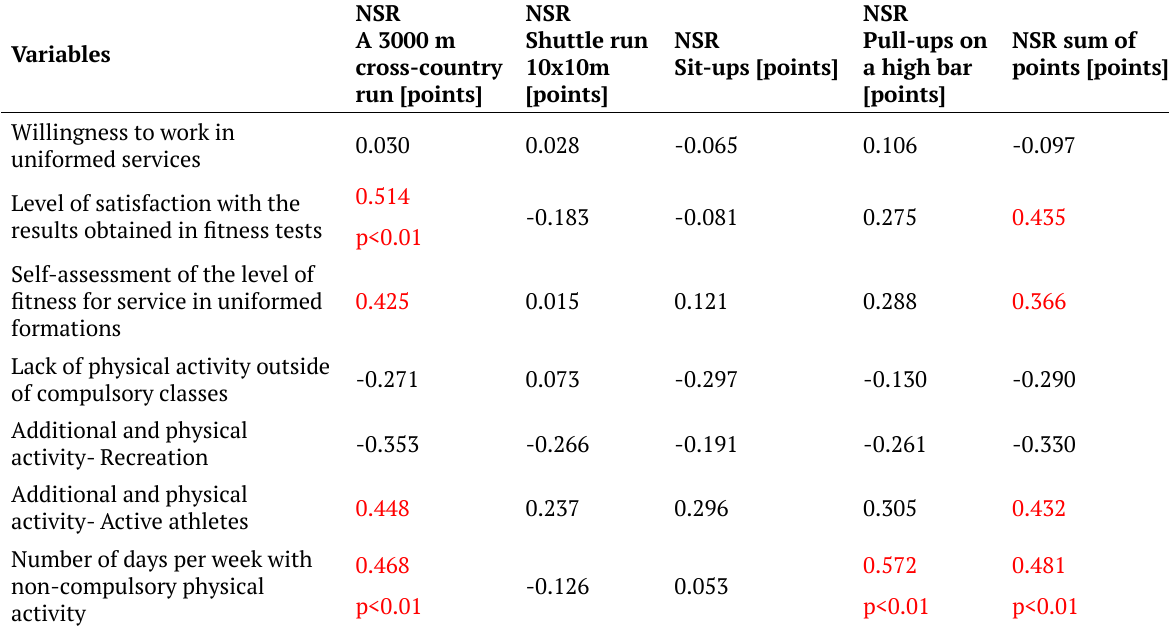
Table 4. Performance in the fitness test vs. research questionnaire (Spearman’s R correlation)